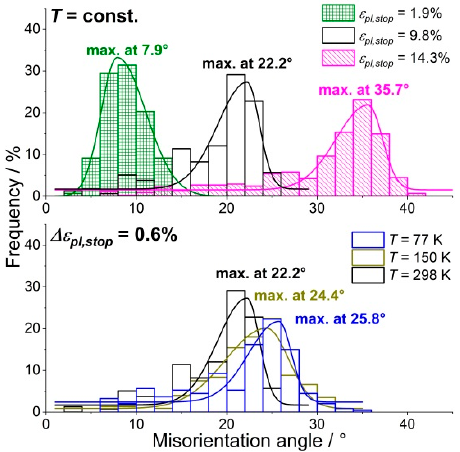
Figure 6. Relative frequency distribution of misorientation angles (2 ◦ bins, presented by histograms) and Bi-Gaussian fit (line diagrams) of respective data set. Influence of plastic strain ε pl , stop on kink band properties in HfNbTaTiZr, deformed at 298 K: 1.9% vs. 9.8% vs. 14.3% (top) and influence of test temperature T on misorientation angle distribution at comparable plastic strains ε pl , stop : 77 vs. 150 vs. 298 K (bottom).